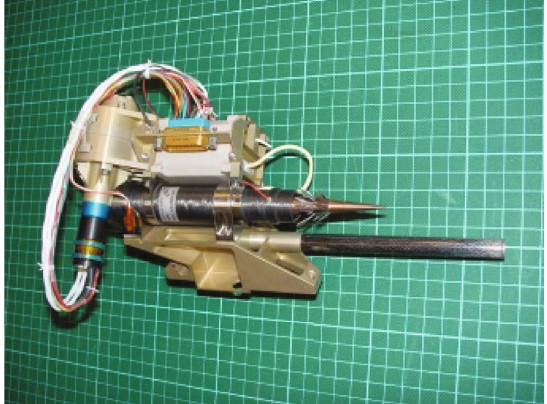
Figure 4: Harpoon anchoring device.